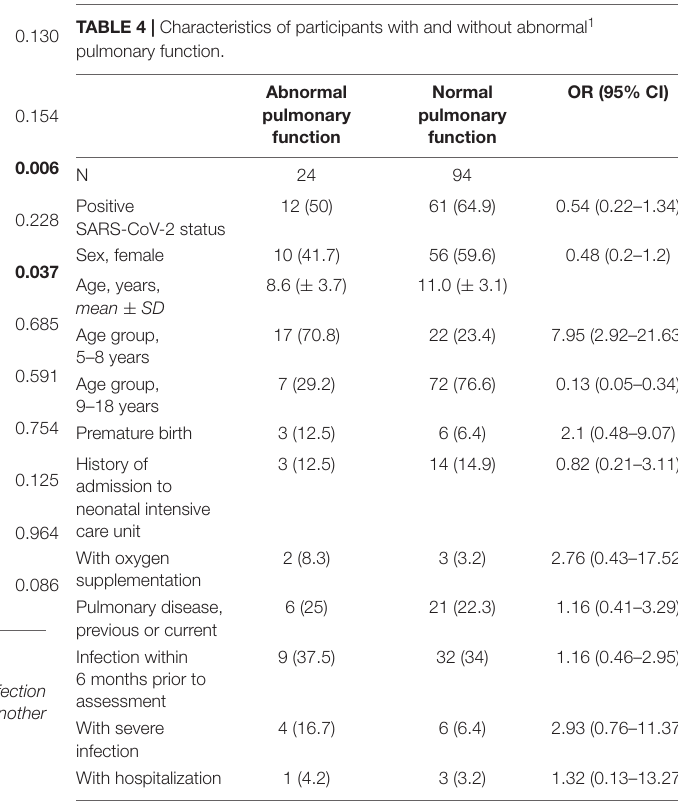
SD, standard deviation; OR, odds ratio; CI, confidence interval. Data are expressed as n (%), unless specified otherwise. 1 Abnormal pulmonary function defined as at least one measured parameter being pathological (LCI 2 . 5% > 7.9, FVC Z-score, FEV 1 Z-score, MEF 75 Z-score, MEF 25 Z-score, DLCO Z-score, DLCO/VA Z-score < − 1.96) or at least one borderline parameter (LCI 2 . 5% > 7.0, FVC Z-score, FEV 1 Z-score, MEF 75 Z-score, MEF